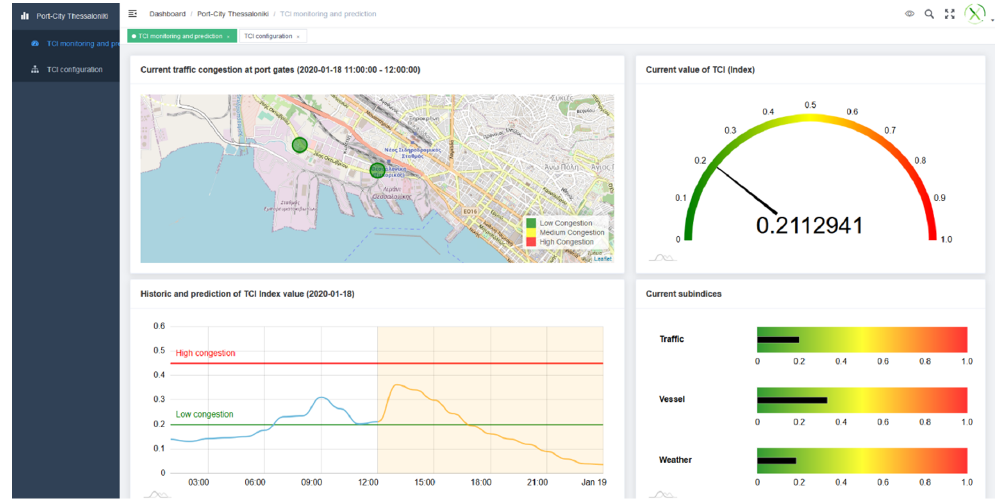
Figure A11. Visualization of the scenario 3.2 in the UI dashboard.